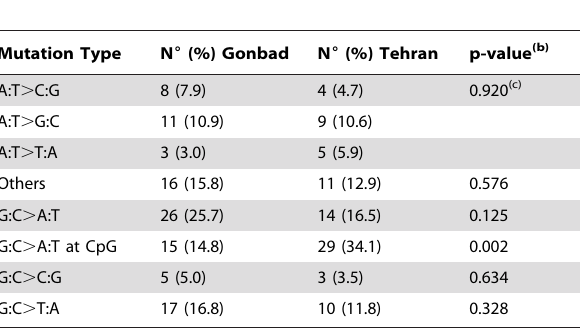
Figure 2. Distribution of TP53 mutation types in ESCC. A: TP53 Mutation types in ESCC from Golestan, exons 2 to 11. Mutations are grouped in categories as defined in the IARC TP53 mutation database (http://www-p53.iarc.fr). B: Comparison of mutation types in exons 5 to 8 of ESCC from Golestan (this study, n=101) with results from Tehran (n=85) and Henan Province, China (n=117) compiled in the IARC TP53 mutation database (http://www-p53.iarc.fr/AdvancedCriteria.asp; search criteria: Esophagus, exons 5 to 8, Squamous Cell Carcinoma, surgery or biopsy, DNA; for China: Linxian and/or Henan, for Iran: Tehran). doi:10.1371/journal.pone.0029488.g002 Table 2. Comparison between TP53 mutation patterns in ESCC of patients from Golestan and Tehran a